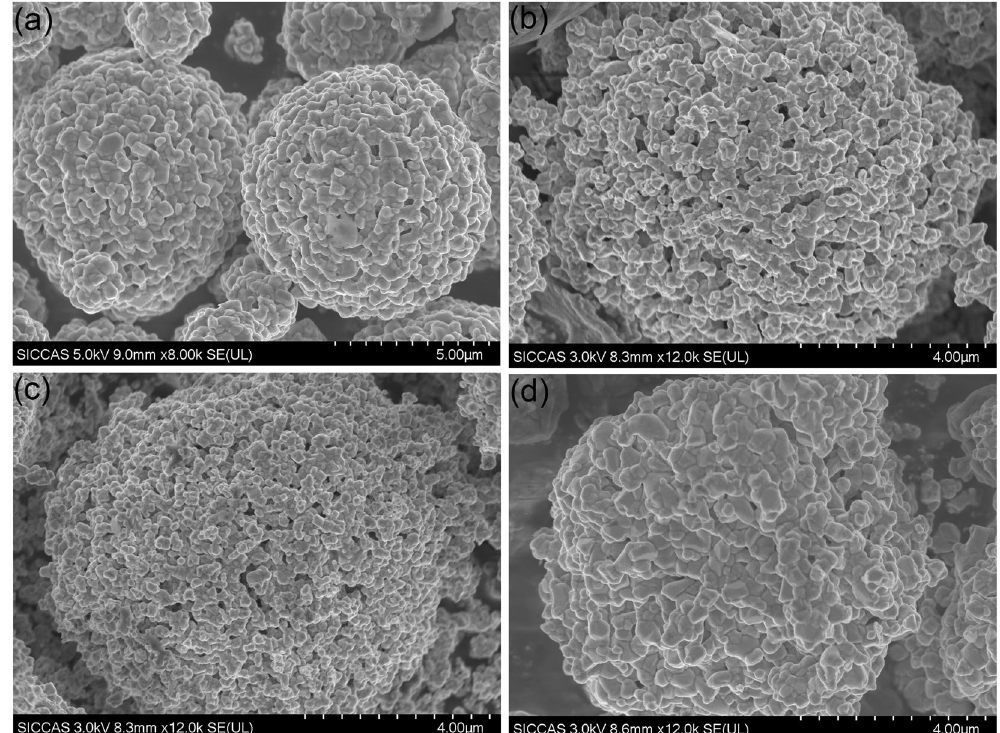
Figure 3. SEM images of cathode samples ( a ) S0, ( b ) S2, ( c ) S4 and ( d ) S6.